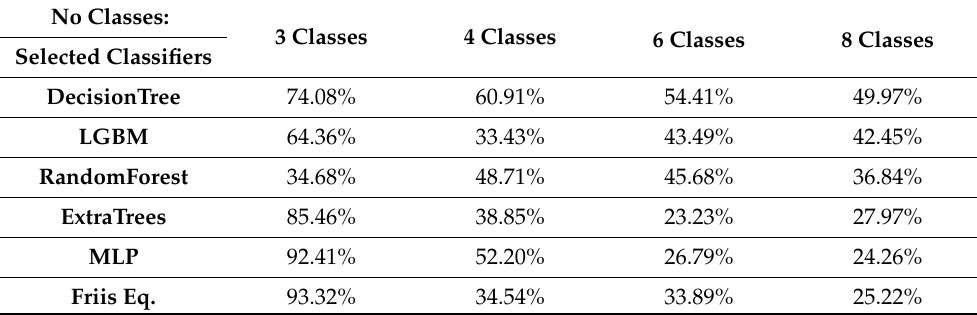
Table 8. Summary table of classifiers’ accuracy ranking, based on APC , for different speed classes (3, 4, 6,